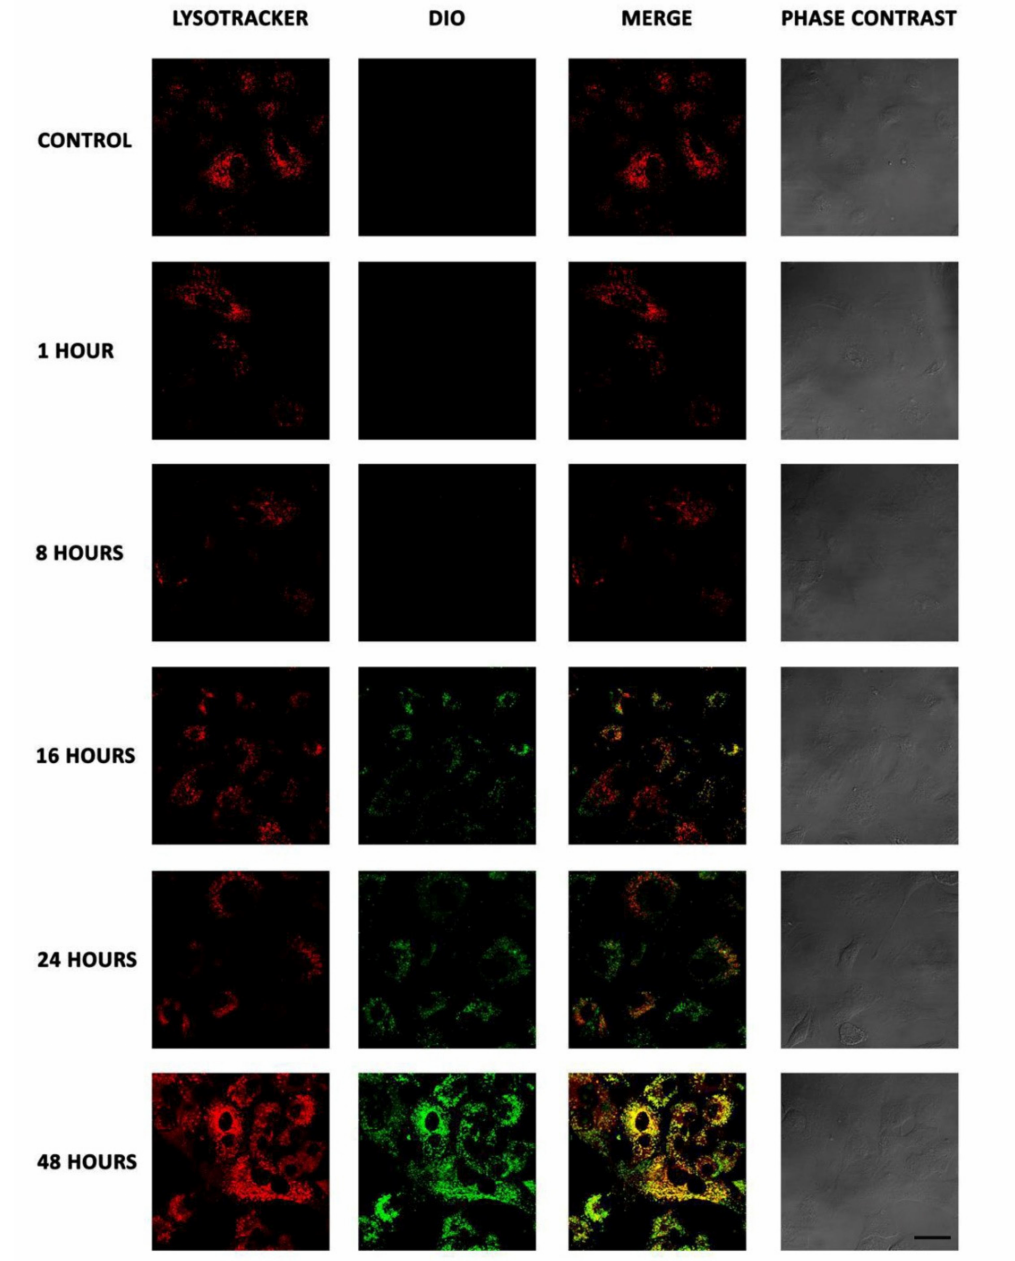
Figure 3. Internalization of NCs by confocal microscopy. A549 cells were incubated with NC-DiO (green) for 1, 8, 16, 24, and 48 h, fixed and incubated with LysoTracker (red) to dye the late endosomes and lysosomes. Merge images show colocalization between NCs and acidic organelles (yellow). Scale bar 30 µ